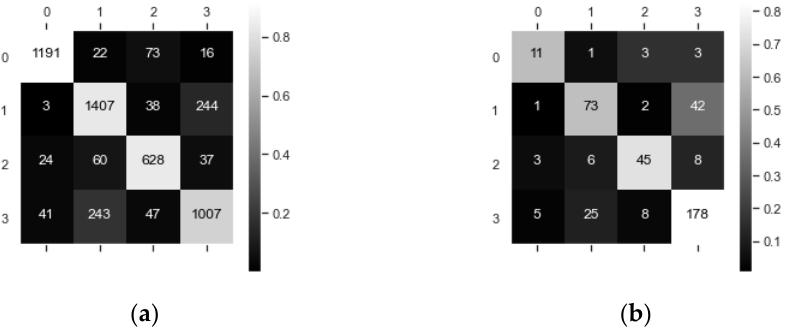
Figure 33. ( a ) Confusion matrix of samples (MFELCM1); ( b ) Confusion matrix of ships (MFELCM1). Table 15. Performance evaluation of base classifiers and MFELCM1.